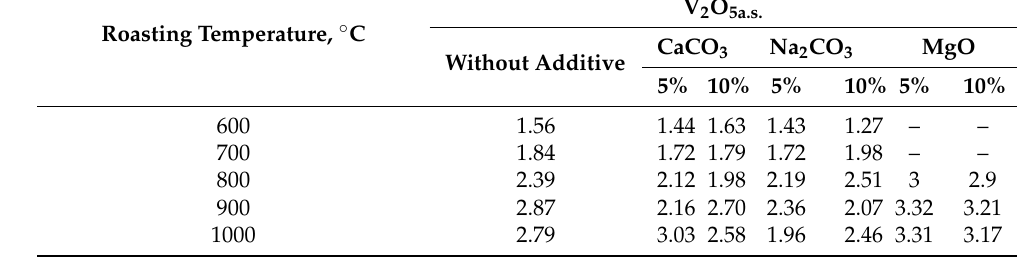
Table 2. Effect of the roasting temperature and addition amount on the V 2 O 5 acid-soluble form content, %wt.